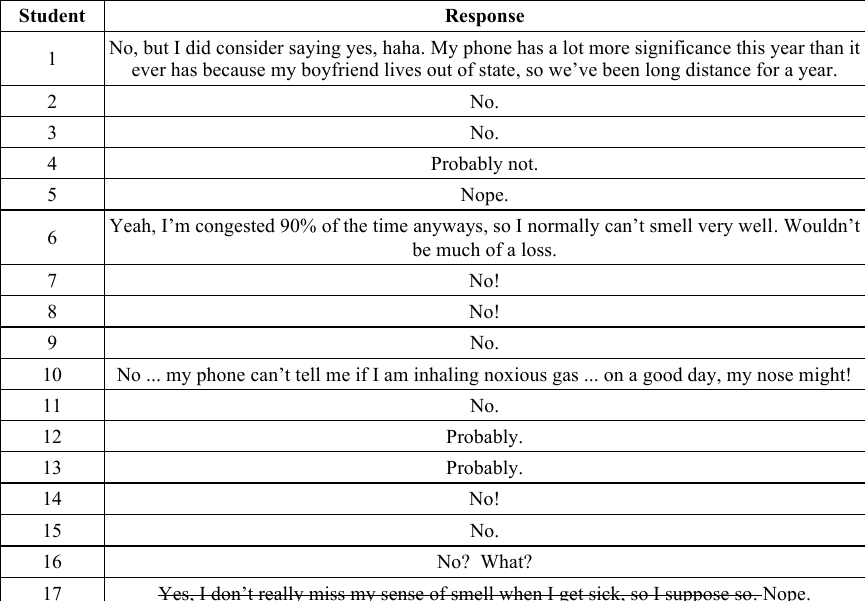
Table 7. Question 7: Would you give up your sense of smell to keep your